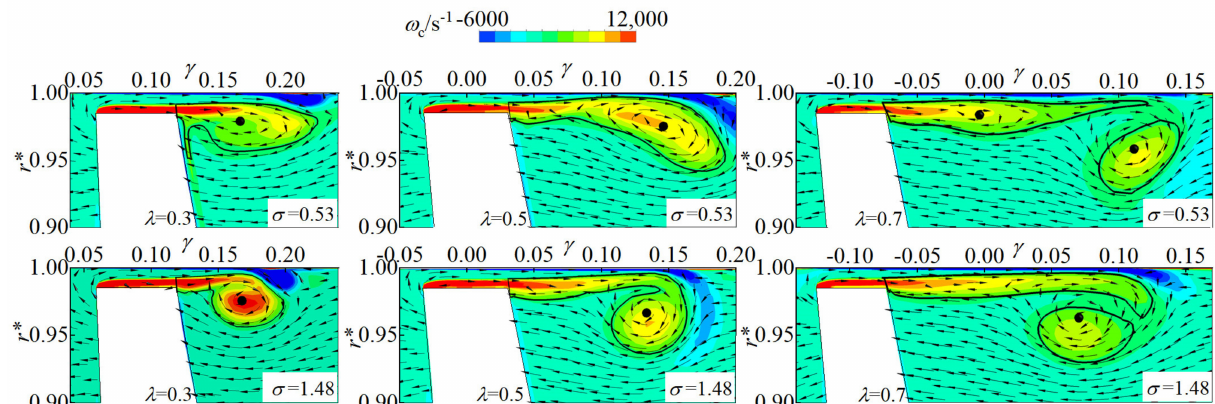
Figure 11. Comparison of the vorticity ( ω c ) distribution on the three planes for the cavitating case (upper) and non-cavitating case (lower) (the solid point is the vortex center, and the black line represents the isovalue of the vorticity ( ω c = 2500 s − 1 )).